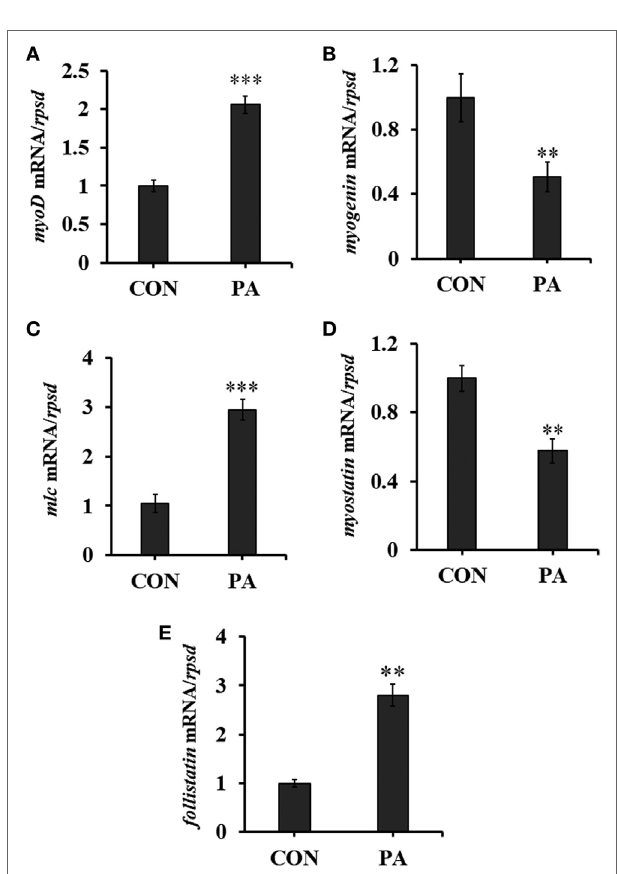
FigUre 2 | Phosphatidic acid (PA) promoted DNA synthesis and G1/S phase transition. Serum starved cells were treated with 10 µM PA for 16 h. (a) The percentages of cells on each phase were analyzed using flow cytometry with PI staining after PA treatment and quantitated ( n = 3). (B) The newly synthesized DNA level was analyzed using flow cytometry with EdU/PI double staining by Click-iT ™ Plus EdU Alexa Fluor ™ Flow Cytometry Assay Kit after PA treatment (F1, cells in G1 phase; F2, cells in S phase; F3, cells in G0 phase; F4, cells in G2 phase) and quantitated ( n = 3). (c) The levels of total and phosphorylated forms of Rb, cyclin E, and Cdk2 were examined by western blot after PA treatment and quantitated ( n = 3). (D) The mRNA expressions of cyclin A and cyclin D were quantitated by quantitative real-time PCR after PA treatment ( n = 6). Results were represented as means with SEs and were analyzed using independent t tests (* P < 0.05, ** P < 0.01, *** P <